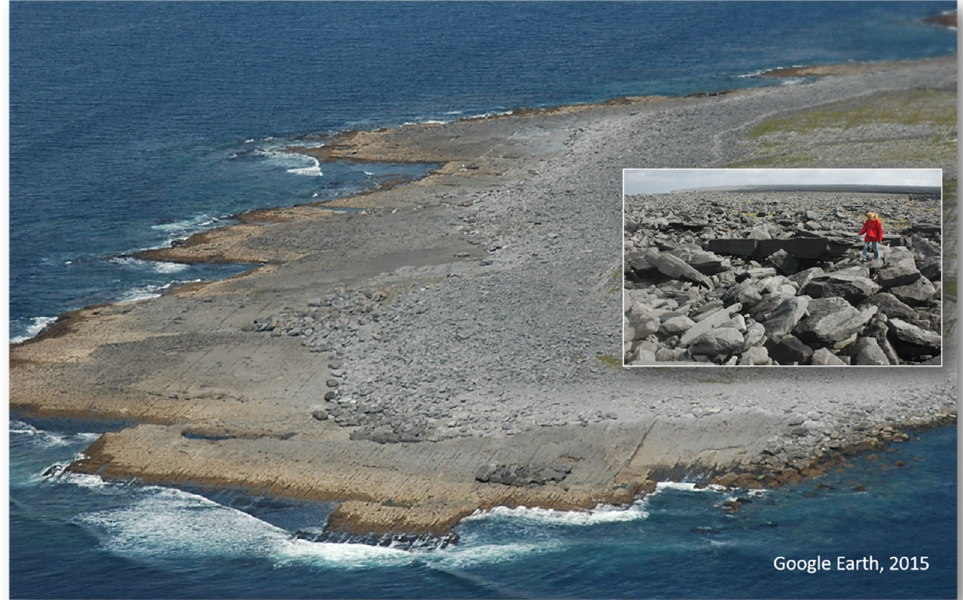
Figure 10. Main boulder “ridge“ on Inisheer with landward slopes of low or no inclination and fields of boulders strewn inland. Along its seaward base, enrichments of large, mostly immobile boulders document the slow erosional tendency of the main formation (compare Figure 11).